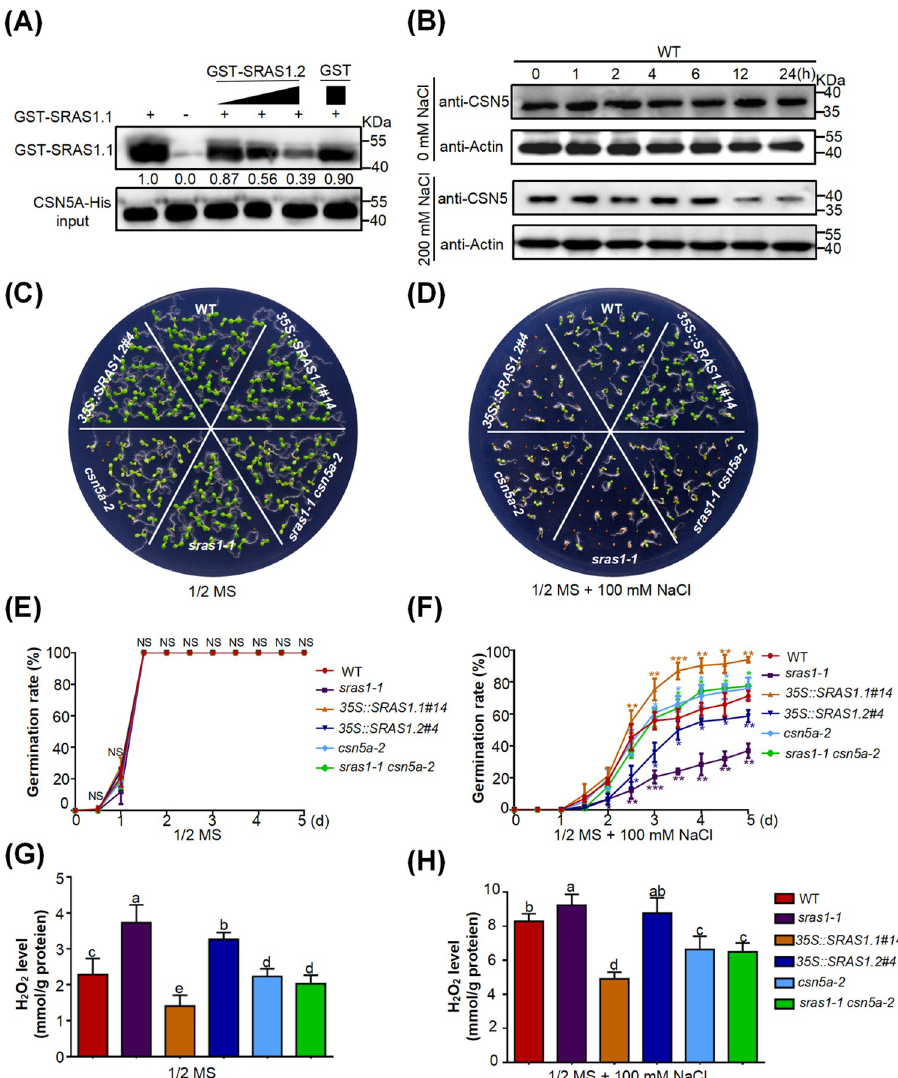
Fig 7. SRAS1.2 inhibits the degradation of CSN5A through affecting interactions between SRAS1.1 and CSN5A. In vitro pull-down assay displaying the changes in the interaction between SRAS1.1 and CSN5A by SRAS1.2 in a dose dependent manner. GST-SRAS1.1 protein combined with GST-SRAS1.2 or GST was incubated with immobilized CSN5A-His. The immunoprecipitated fractions were detected by anti-GST antibody. The gradient indicates an increasing amount of GST-SRAS1.2. CSN5A-His input is shown in the lower panel. (B) Immunoblot analysis of CSN5 protein levels under salt stress. Total protein extracted from 7-day-old WT seedlings treated with or without 200mM NaCl 0, 1, 2, 4, 6, 12 and 24 hours. The expression levels of CSN5 were detected with anti-CSN5 antibody. (C)-(D) Germination phenotype of WT, sras1-1 , 35S :: SRAS1 . 1 , 35S :: SRAS1 . 2 , csn5a-2 and sras1-1 csn5a-2 seedlings grown on 1/2 MS medium with or without 100mM NaCl. Images were taken 7 days after germination. (E)-(F) Germination rates of WT, sras1-1 , 35S :: SRAS1 . 1 , 35S :: SRAS1 . 2 , csn5a-2 and sras1-1 csn5a-2 seedlings grown on 1/2 MS medium with or without 100 mM NaCl. The values are the mean ± standard deviation from three biological replicates. ( � P < 0.05, �� P < 0.01, ��� P < 0.001), NS, not significant (P � 0.05). (G)-(H) H 2 O 2 contents in WT, sras1-1 , 35S :: SRAS1 . 1 , 35S :: SRAS1 . 2 , csn5a-2 and sras1-1 csn5a-2 seedings with or without 100 mM NaCl. Different letters indicate that values are significantly different at P < 0.01. The data shown are representative of three independent experiments. seedlings, whereas the H O level was lower in csn5a-2 mutant seedlings. And the H O level 2 2 2 2 of sras1-1 csn5a-2 seedlings was comparable to that of csn5a-2 , indicating that CSN5A acted downstream of SRAS1 (Fig 7G and 7H).